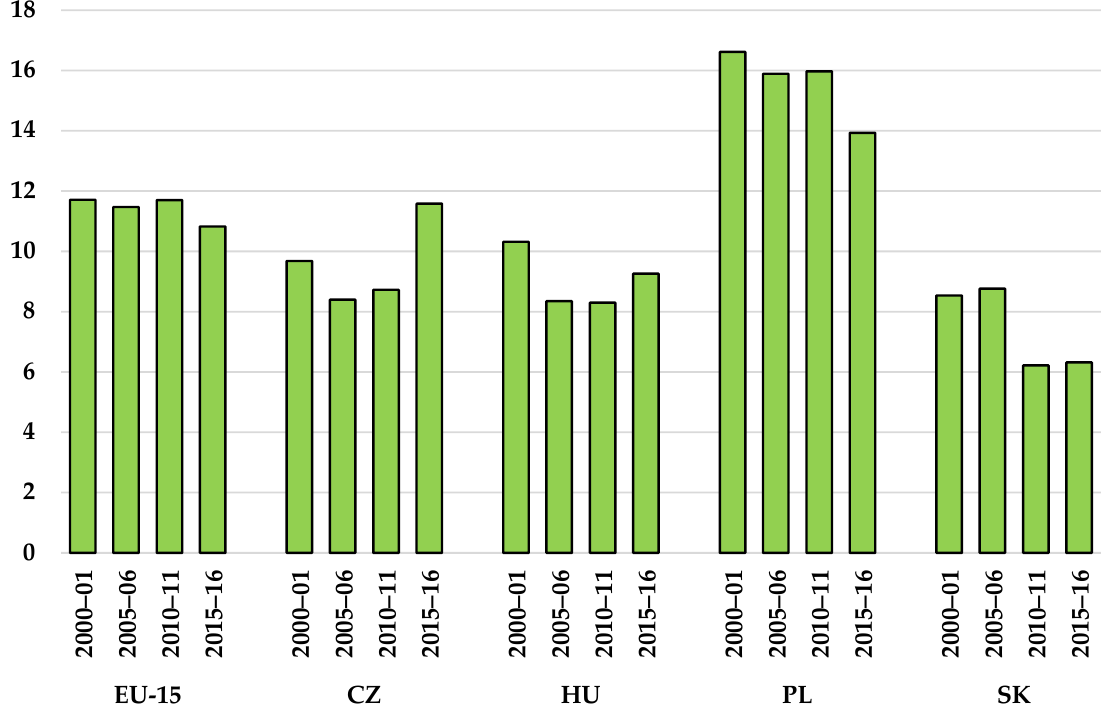
Figure 2. Energy intensity of agricultural land (TJ/1000 ha UR). Source: Own calculations based on WIOD Environmental Accounts and WIOD national input–output tables.